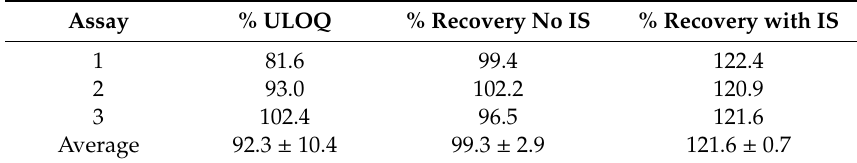
Table A5. Lutein recovery